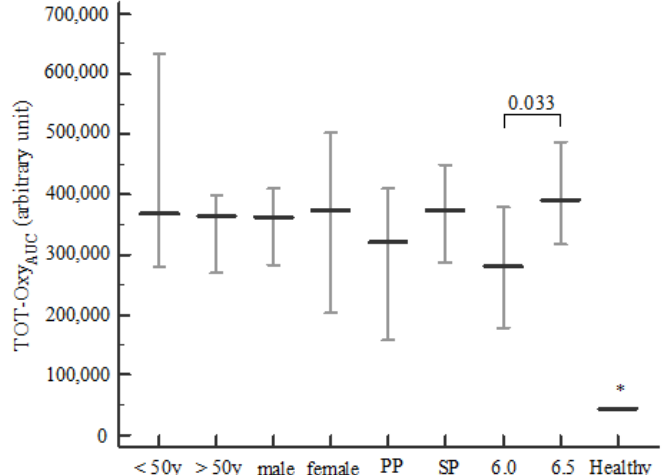
Figure 2. Cortical activation distribution at baseline according to age, sex, phenotype, and EDSS scores. Legend: data are expressed as median values and respective 95% confidence intervals. * p < 0.05, in respect to all other parameters.